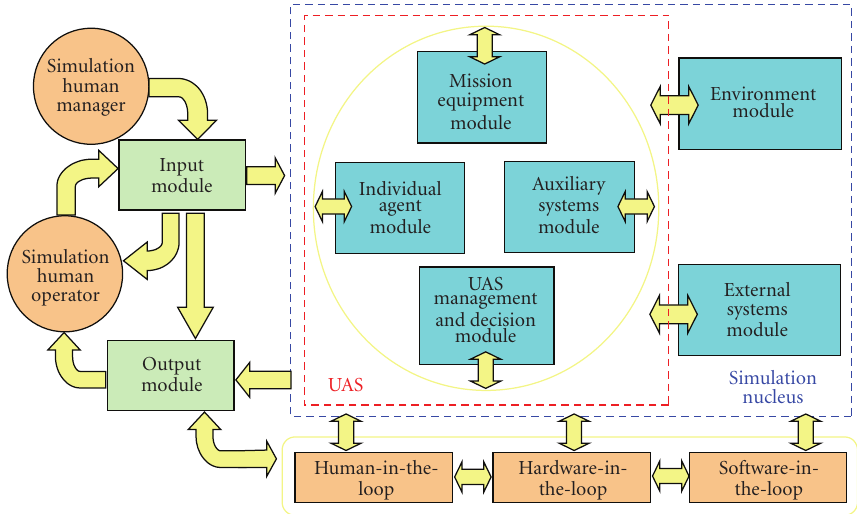
Figure 1: UAS-SE—top-level system block